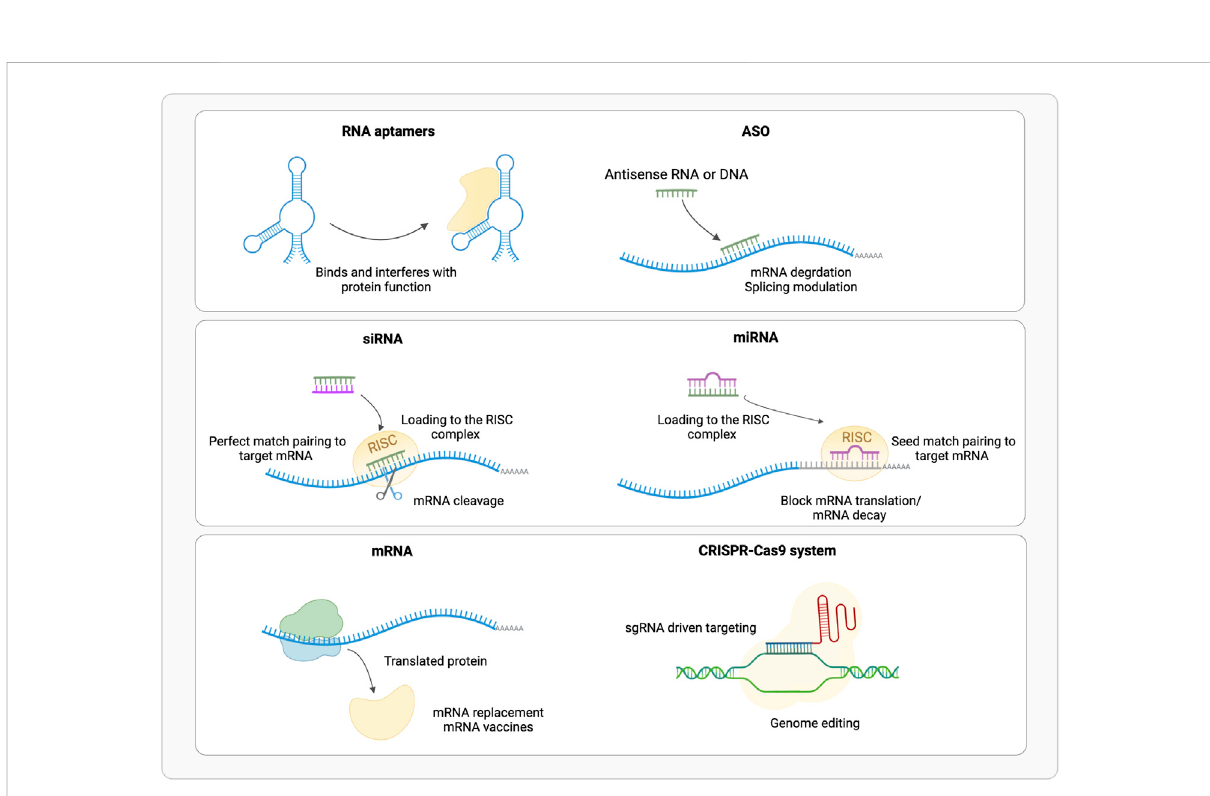
FIGURE 1 Schematic representation of the available RNA based therapeutic approaches (ASO, Antisense Oligonucleotide; RISC, RNA Inducing Silencing Complex). (Realized with Biorender).